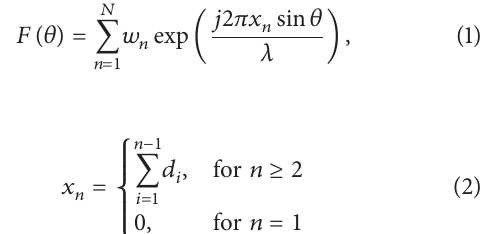
algorithm (BSA) is proposed for linear antenna array pattern synthesis with prescribed nulls at interference